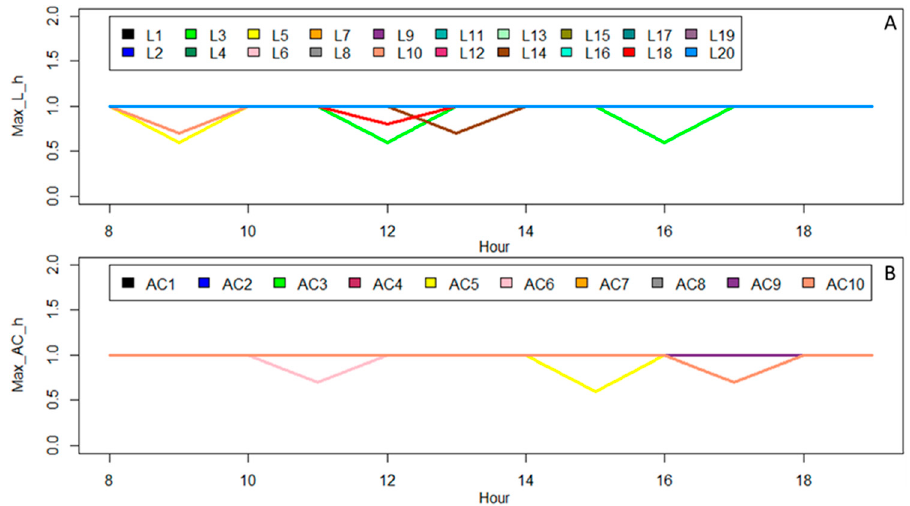
Figure 9. Coe ffi cients regarding maximum allowed power reduction of lights and ACs. ( A ) amount of Figure 9. Coefficients regarding maximum allowed power reduction of lights and ACs. ( A ): amount